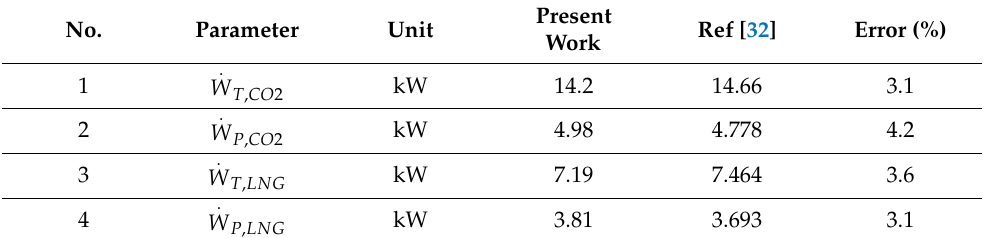
Table 10. The comparison of key parameters in the present work and in